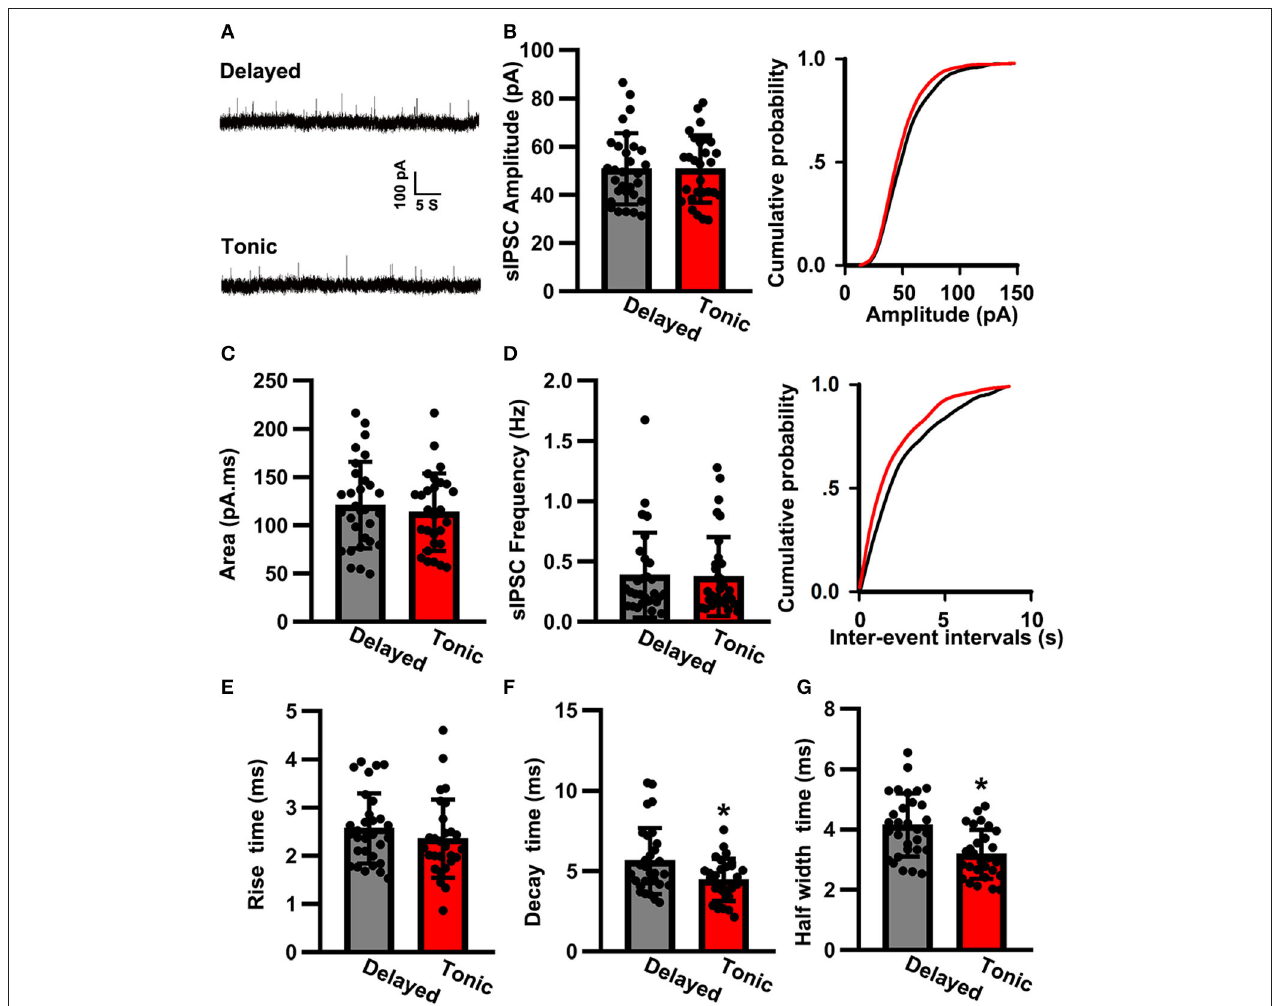
FIGURE 4 | The spontaneous inhibitory postsynaptic current (sIPSC) properties of SG neurons. (A) Examples of sIPSC in two groups. The time scale bar is 5s and the amplitude bar is 100pA. Comparison of amplitude (B) , area (C) , frequency (D) , rise time (E) , decay time (F) , and half-width time (G) of sIPSC between delayed-firing pattern and tonic-firing pattern neurons. Data were shown as mean ± SEM. * p <